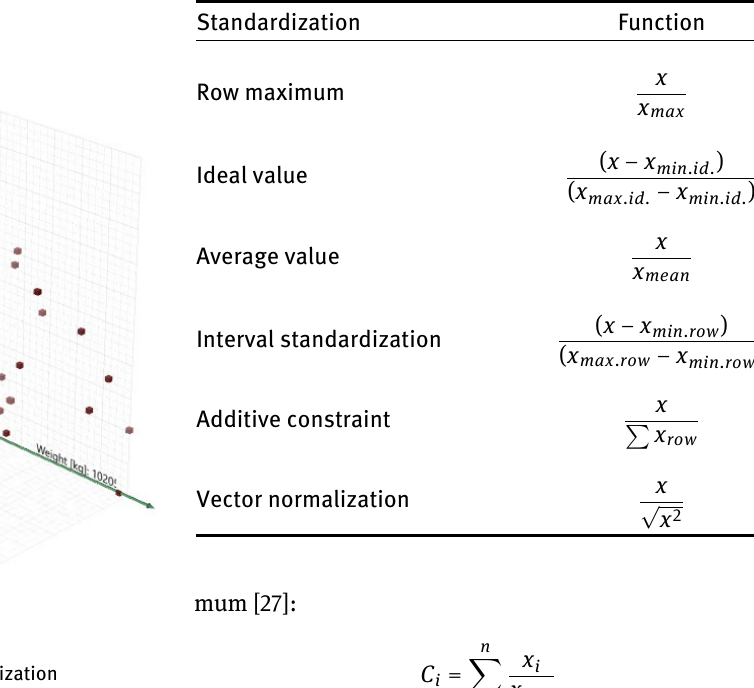
Table 5: Functions of linear